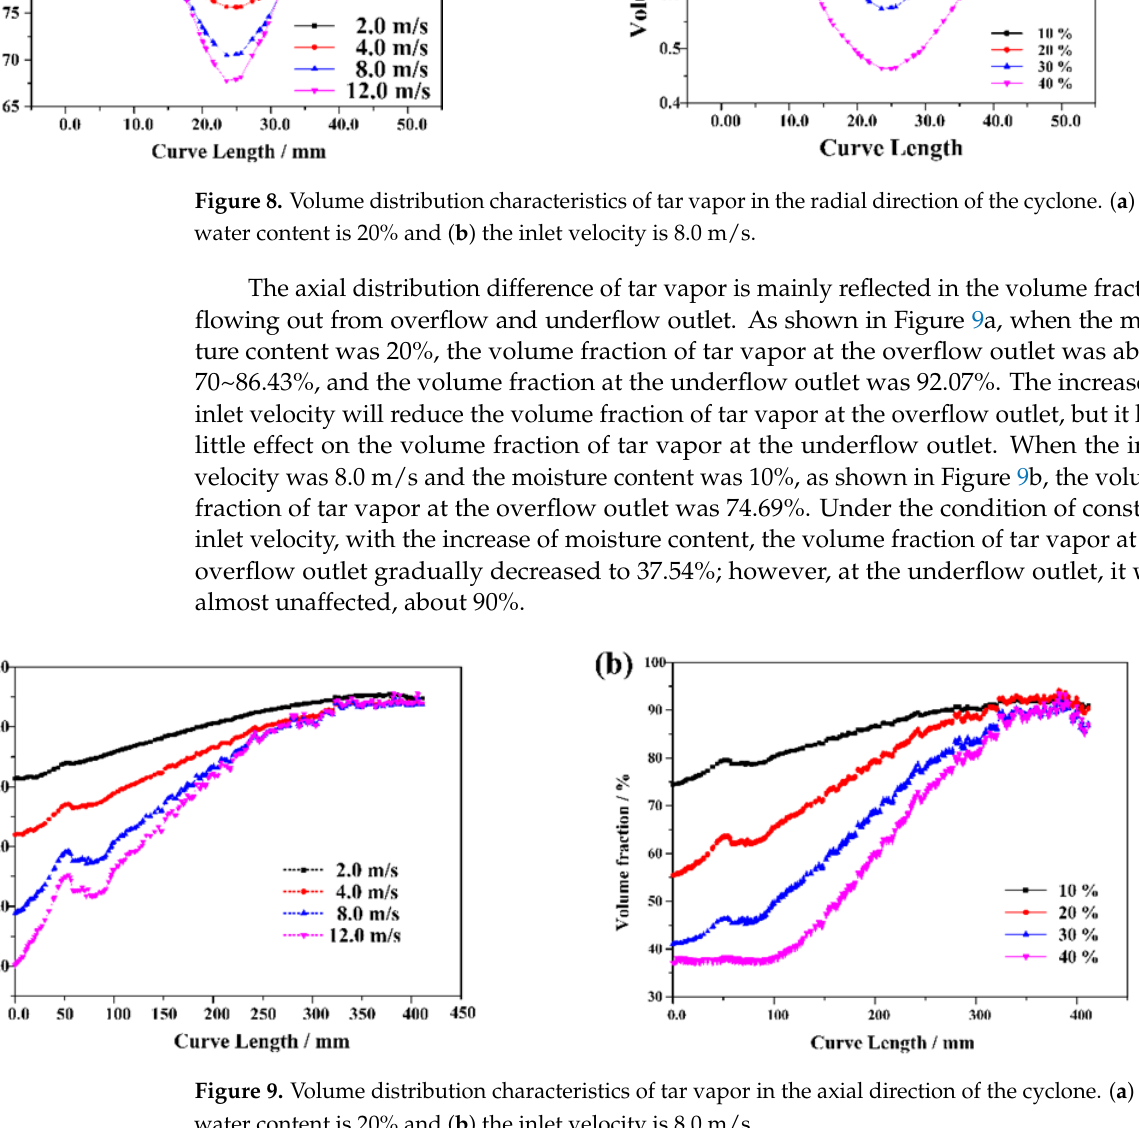
Figure 9. Volume distribution characteristics of tar vapor in the axial direction of the cyclone. ( a ) The water content is 20% and ( b ) the inlet velocity is 8.0 m/s.